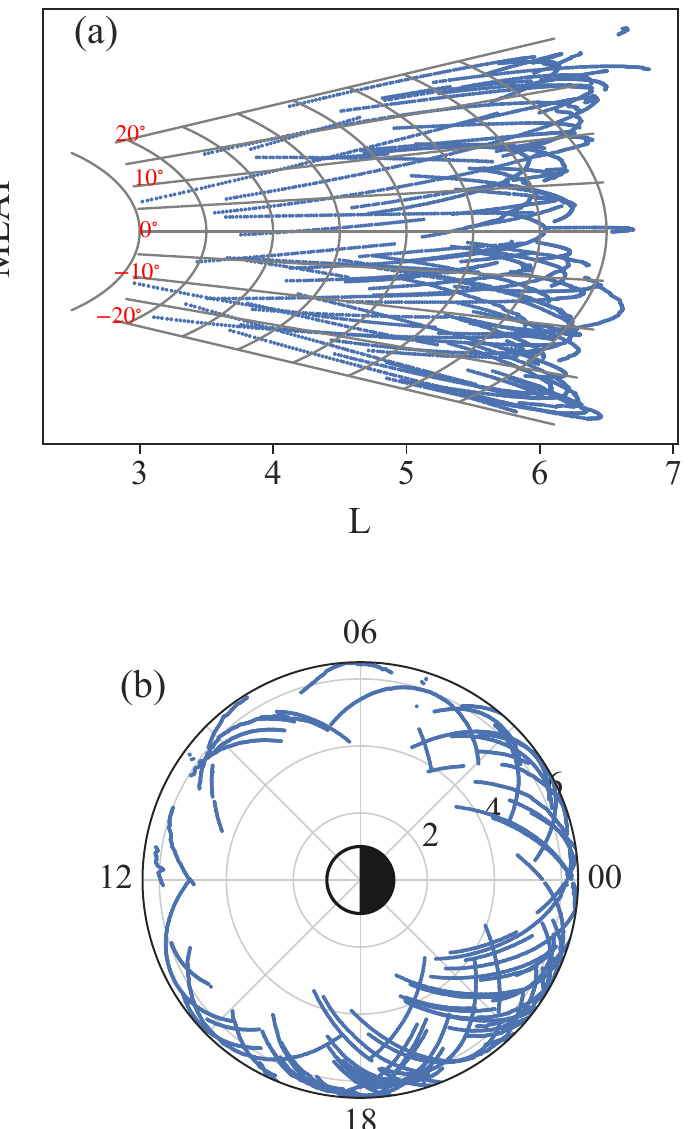
Figure 6. ( a ) Distribution of events in magnetic latitudes and L shell. ( b ) Spatial distribution of events in magnetic local time and L